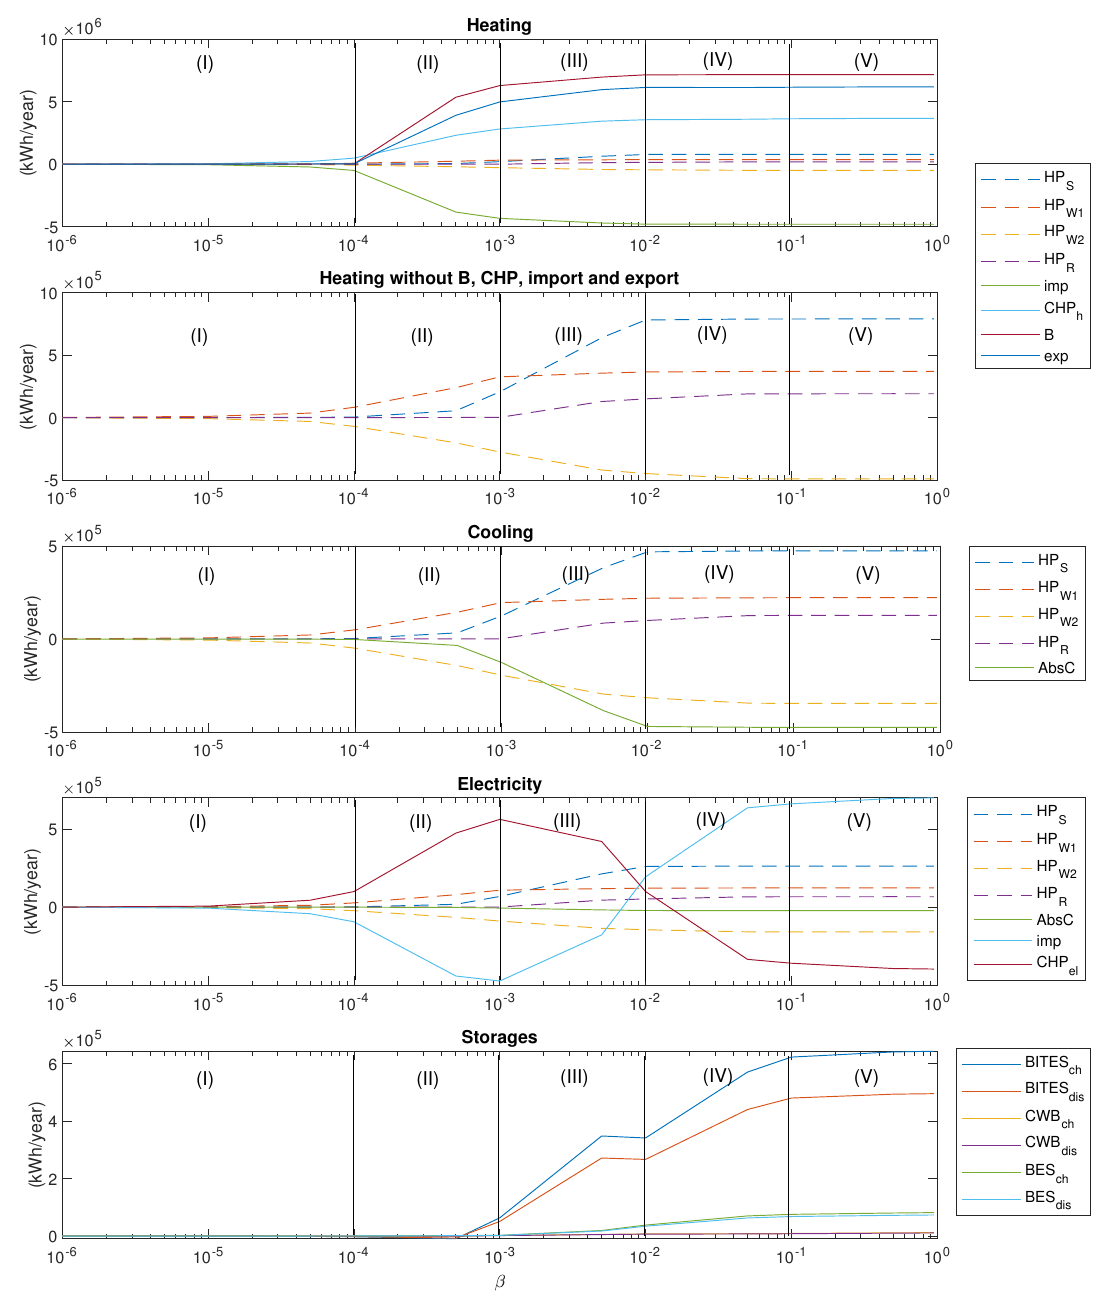
Figure 6. The change in the total energy per year (consumed, produced or stored) of each technology compared to the cost optimal case versus beta for heating, cooling, electricity, and